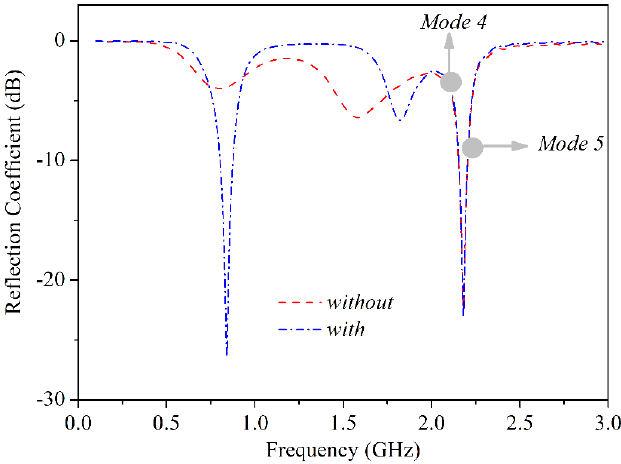
Figure 6. |S 11 | with and without the shorting pin ② for the proposed T-shaped antenna.